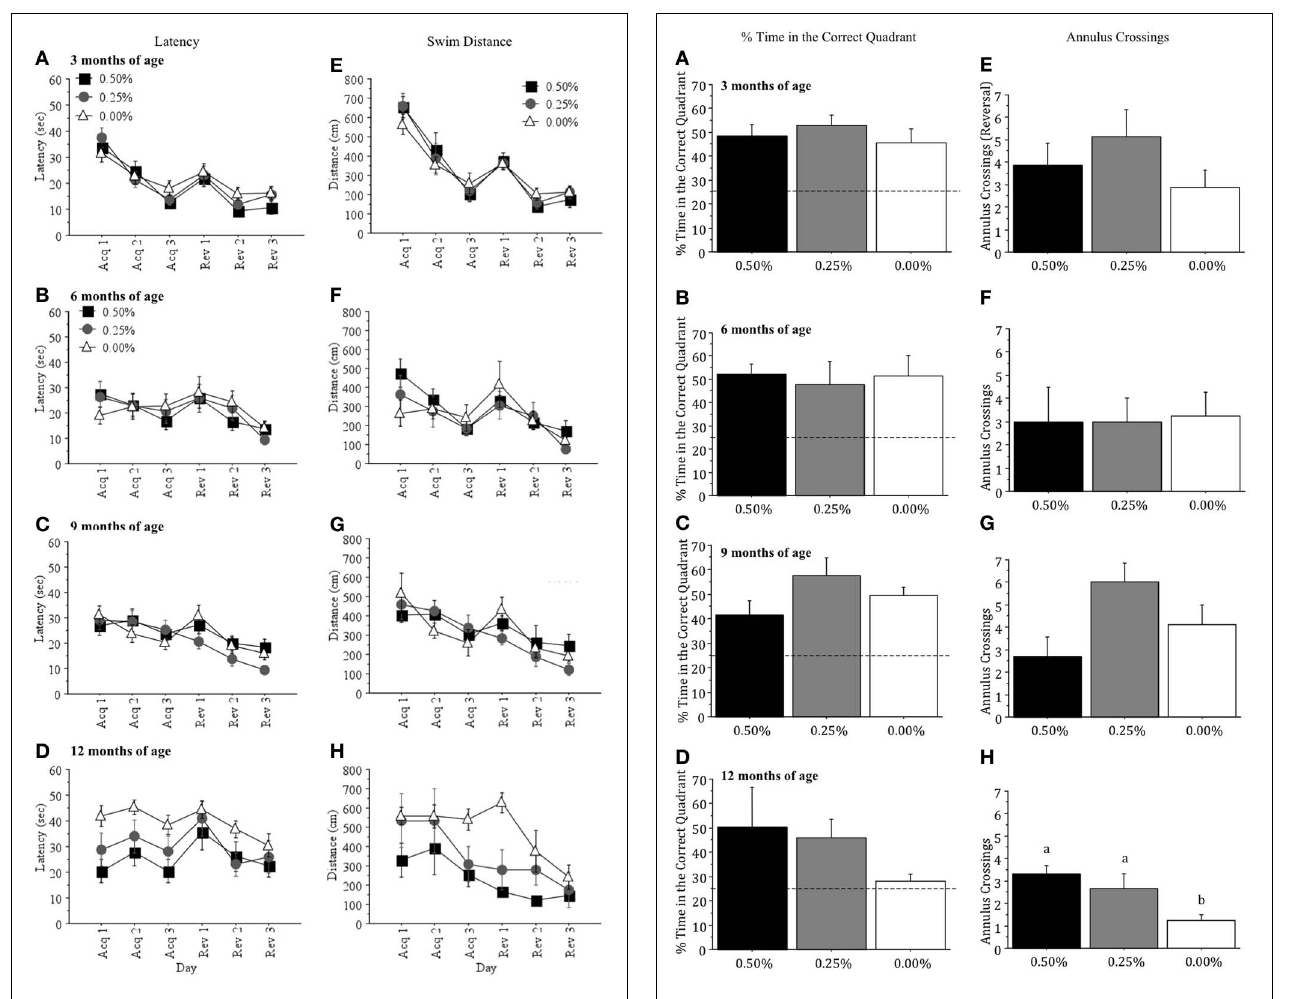
FIGURE 1 | Mean ( ± S.E.M.) latency (sec) and swim distance (cm) to find the hidden platform during acquisition and reversal training in the Morris water maze for mice receiving 0.50, 0.25, and 0.00% Timoptic-XE at 3 (A,E), 6 (B,F), 9 (C,G), and 12 (D,H) months of age.